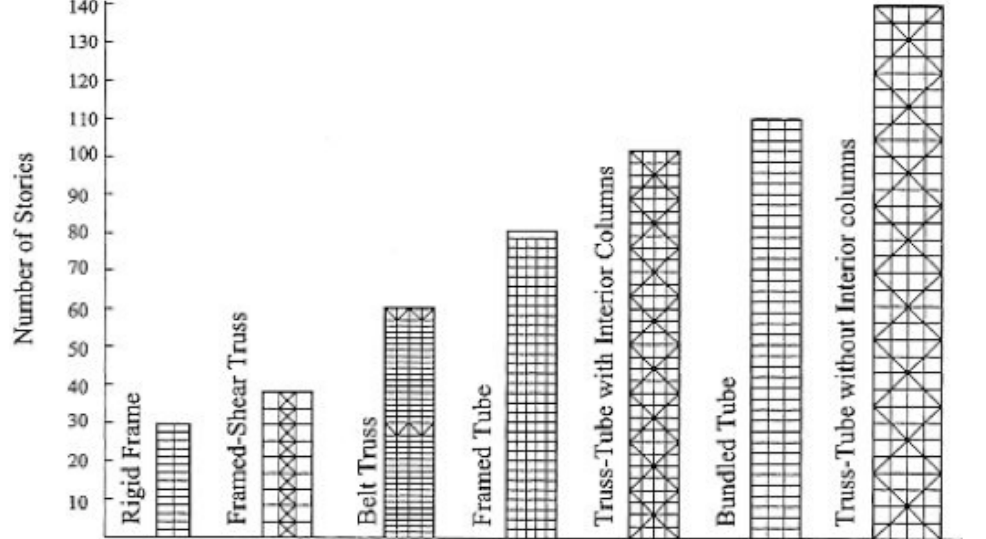
Figure 1. Classification of tall building structures by Fazlur Khan (top: Steel; bottom: